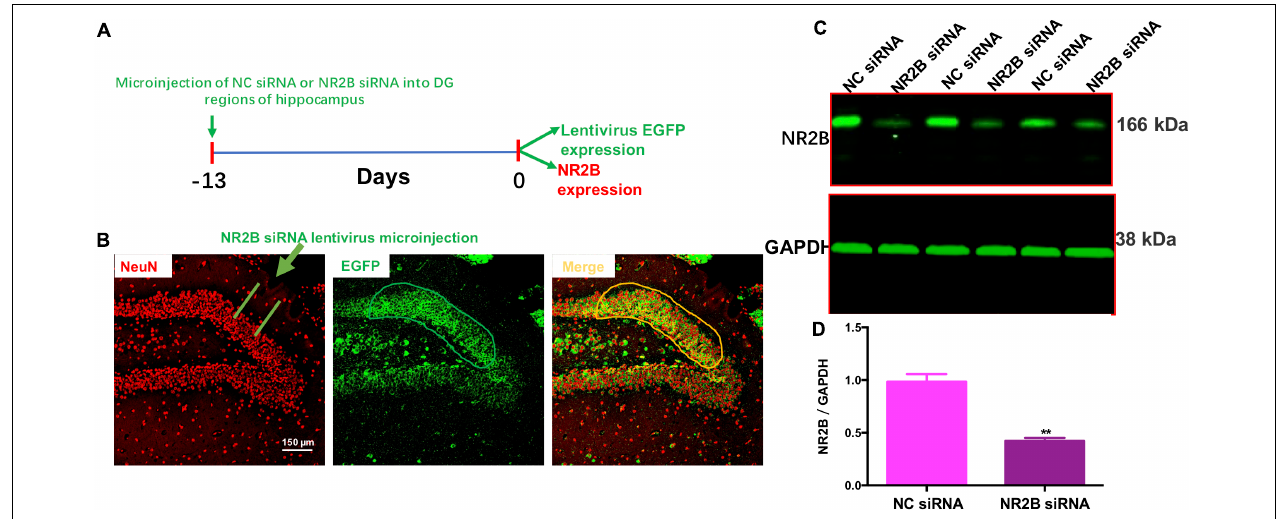
FIGURE 5 | Lentivirus-mediated NR2B knock-down in the dentate gyrus. (A) Experimental procedure for the test schedule. NC siRNA or NR2B siRNA were microinjected into the hippocampus following a 13-day acclimatization. (B) NC siRNA or NR2B siRNA were well-expressed in the hippocampal DG regions as indicated by the merged images, which include nuclear staining with DAPI (blue) and green fluorescent protein (GFP, green) observed under a fluorescence microscope. Scale bars = 200 µ m. (C,D) The expression of NR2B was significantly decreased by NR2B siRNA in the hippocampus of mice. Data are expressed as means ± SEM ( n = 3; ∗∗ P < 0.01 compared with NC siRNA